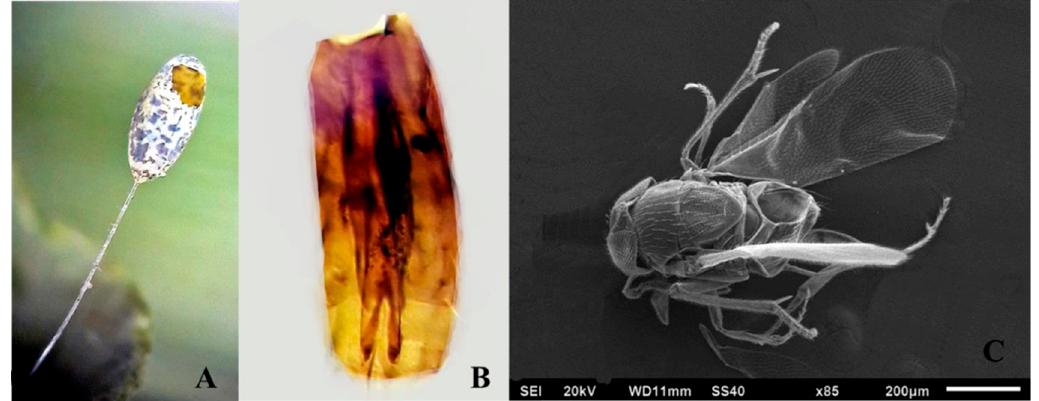
Figure 1. ( A ) Chorion of chrysopid egg following emergence of M. chrysopae , ( B ) Male genitalia, ( C ) Female M. chrysopae.